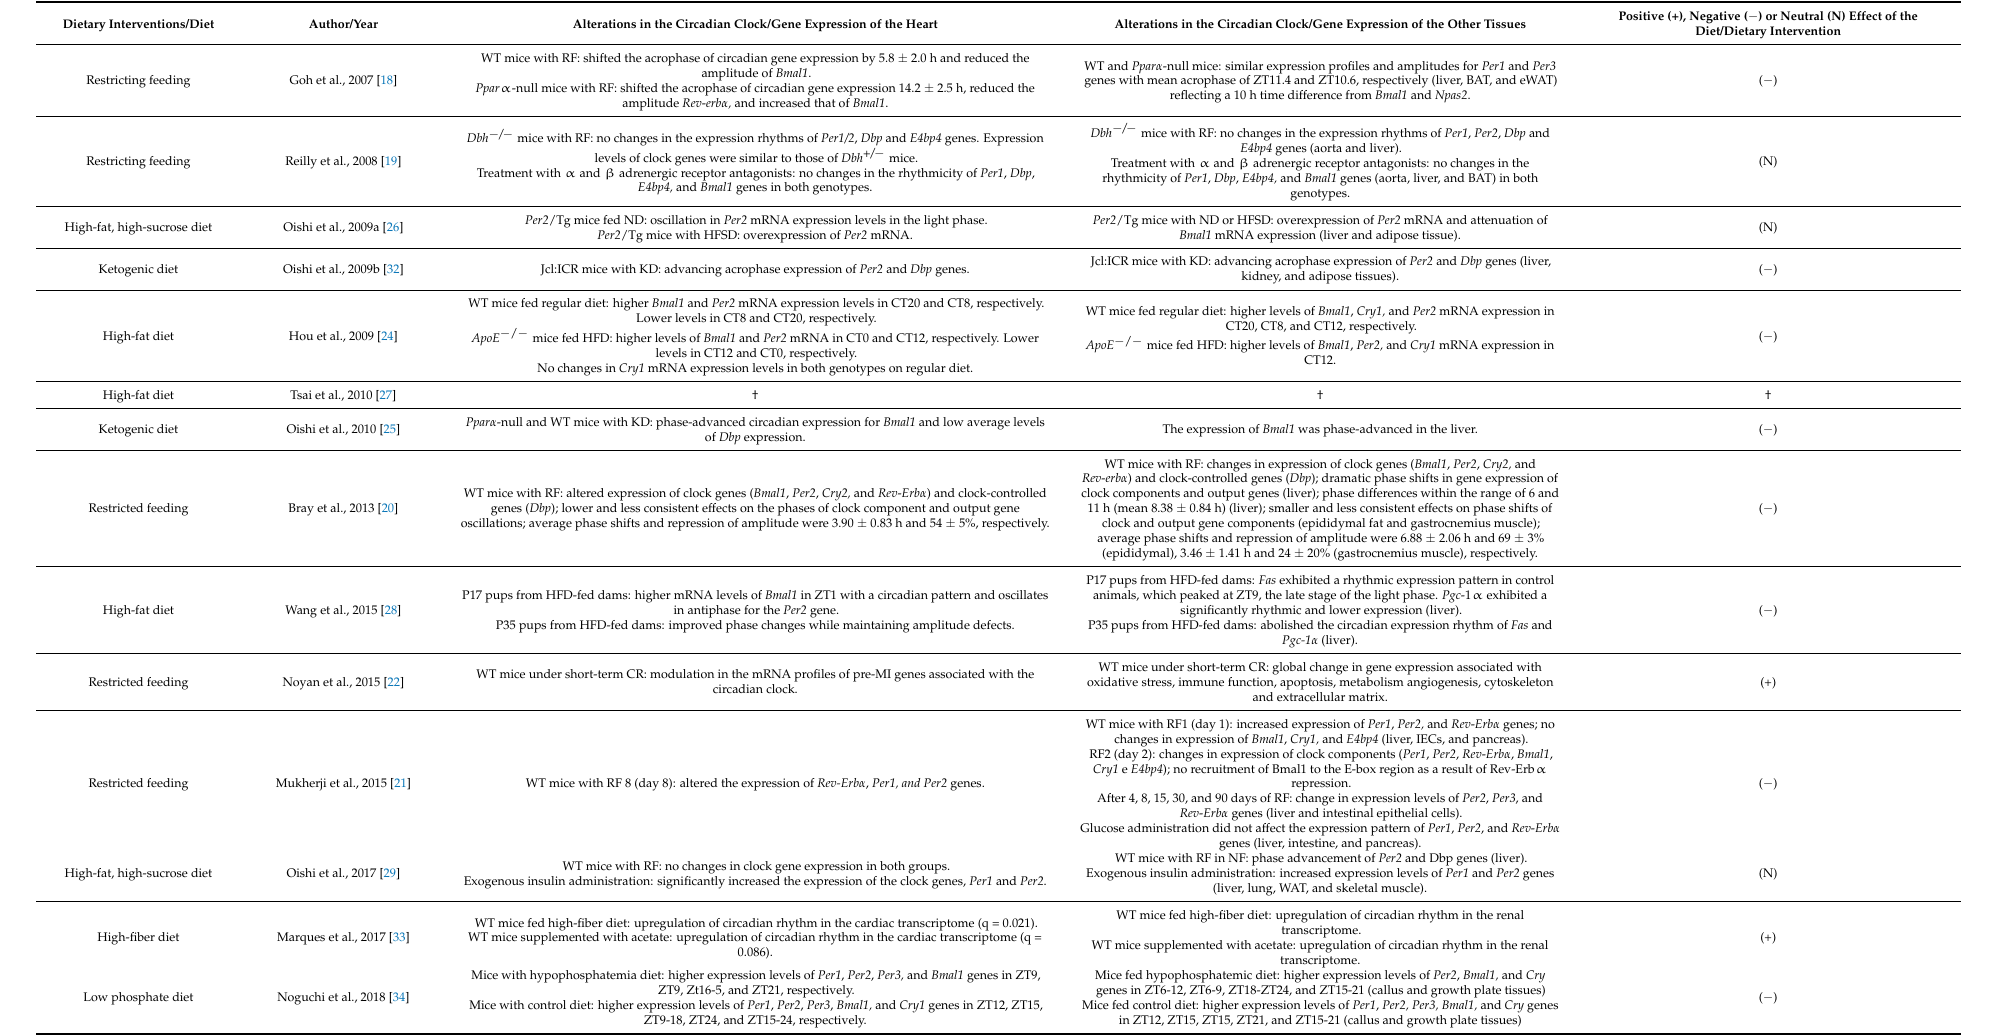
Table 3. Authors, year of publication, and the results